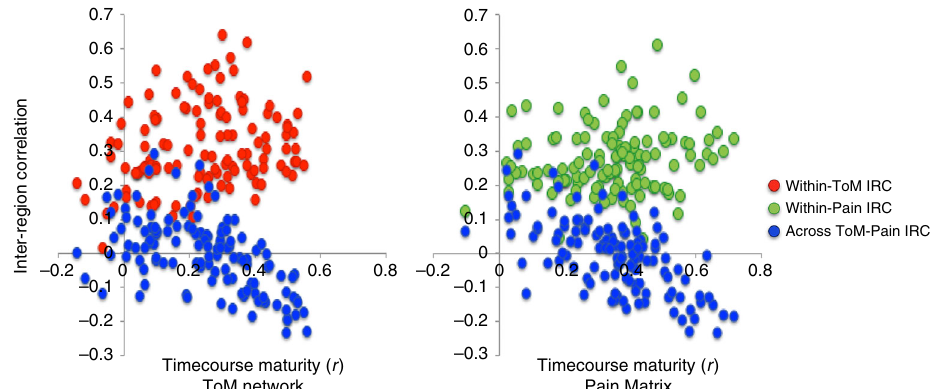
Fig. 5 Relating functional maturity to inter-region correlations. In both networks, timecourse maturity (i.e., how correlated each child ’ s timecourse is to the average adult timecourse (pearson ’ s r ), x -axis) is predicted by the extent to which the responses in ToM and Pain networks are anti-correlated ( z -scored correlation values, y -axis). Both scatterplots show these values for all children ( n b = .05, t = .48, p = .63, effect of age: b = .3, t = 2.5, p = .01, effect